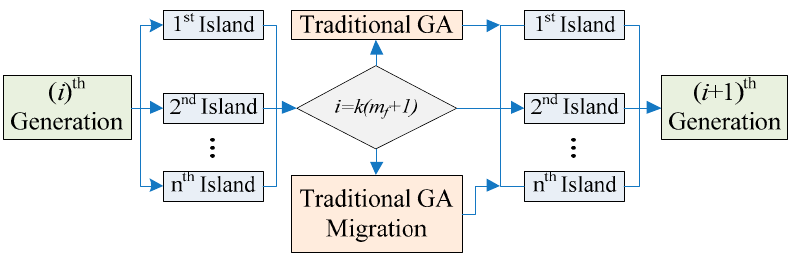
Figure 8. Evolutionary process of the multi-island genetic algorithm (MIGA).